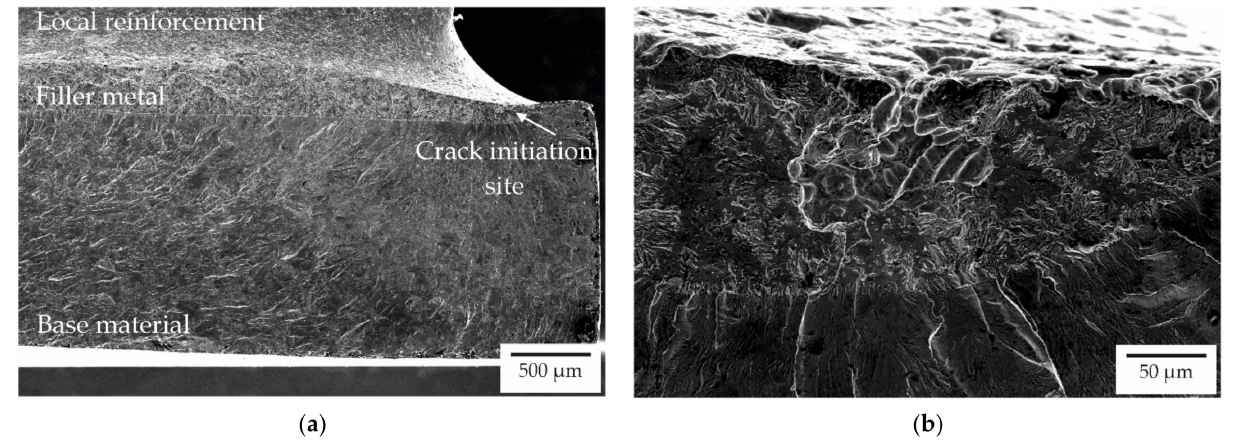
Figure 9. Fracture surface analysis of a brazed specimen: ( a ) overview; ( b ) crack-initiating defect.